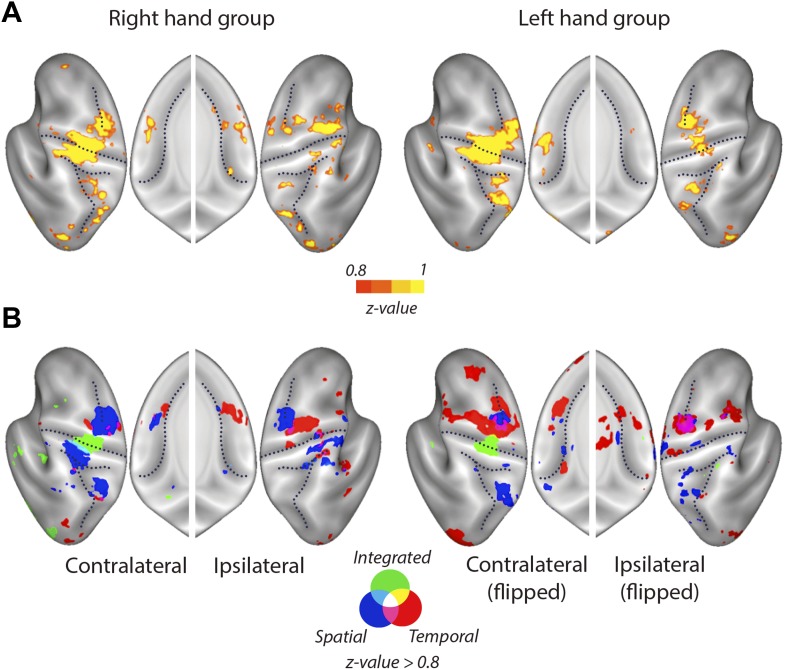
Mean searchlight classification accuracy results displayed as in Figure 4, split by group trained on the right and left hand.(A) Classification accuracy results (z-values). Yellow scale indicates above chance classification by the overall classifier. Results are presented a threshold of z = 0.8 (chance level: z = 0). (B) Blue, red, and green colours stand for above chance classification of spatial, temporal, and integrated patterns, respectively.